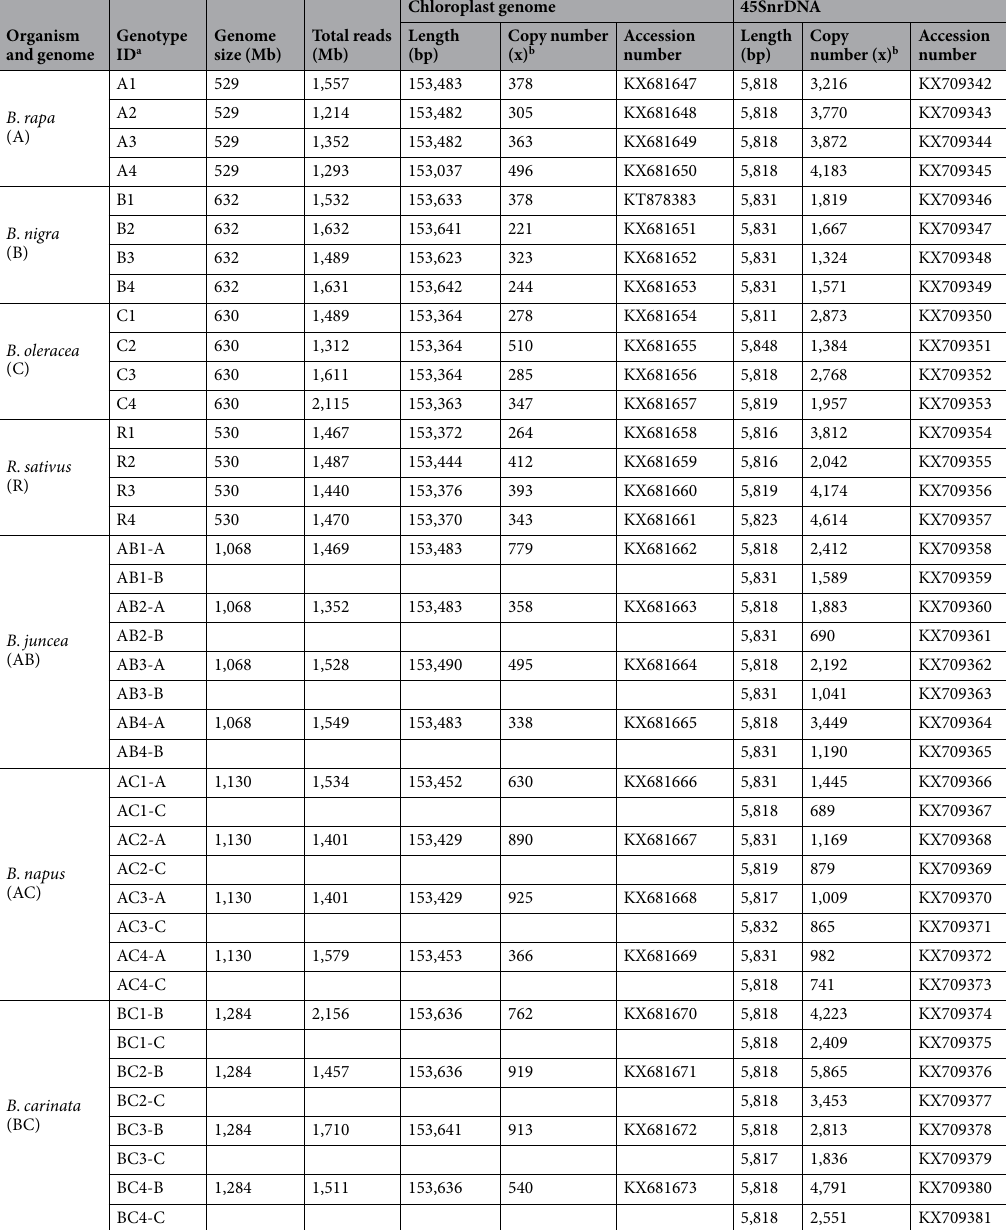
Table 1. Summary of chloroplast and 45SnrDNA assemblies from 28 Brassica and Raphanus genotypes. a rDNA from tetraploids was designated as A, B, or C based on the parental genome or sub-genome type. The complete details and list of organisms can be found in Table S6. b Copy numbers of chloroplast and 45SnrDNA were estimated based on average read depth mapping and converted into the corresponding haploid genome